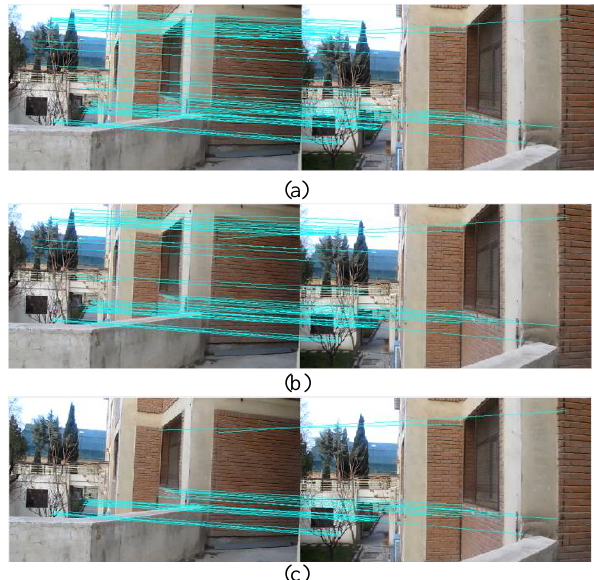
Figure 3. a. Extracted matched points, b. Non-obstacle points are removed and the remaining obstacle candidate points, c.